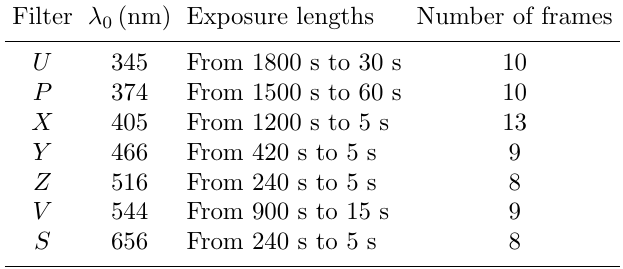
Fig. 1. Map of the observed area in the red (cid:12)lter (DSS1 Red from SkyView). Table 1. Log of observations. The columns give the (cid:12)lter name, the mean wave- lengths of the standard system, the range of exposure lengths and the total number of frames in each